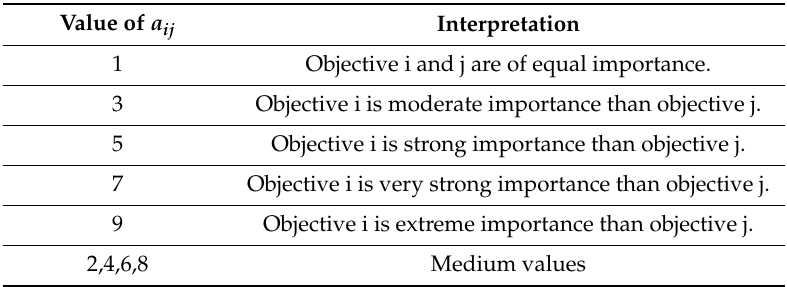
Table 4. The comparison scale in AHP method (source [11]).